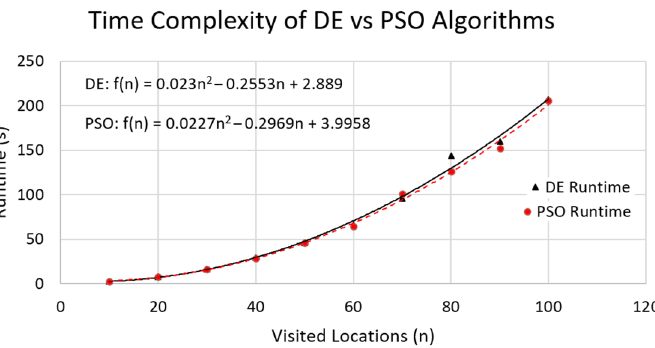
Figure 8. Box plot comparison of the total travel distance (km) from 10 replicated runs between the PSO and DE algorithms (instances 1, 20, 40 and 50).